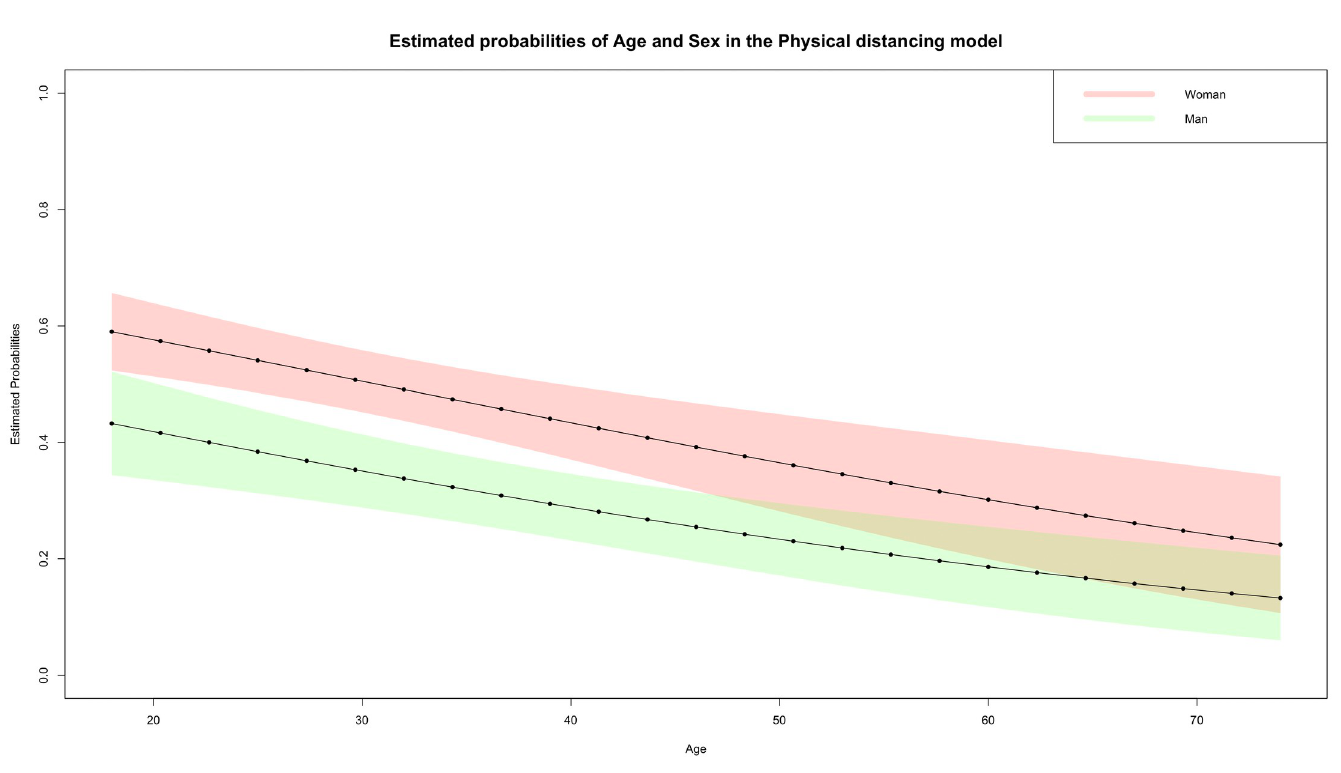
Fig 2. Probabilities estimated by logistic regression for age in the mask use (left) and hand washing (right) models with confidence intervals of 95%. The probabilities shown in the figure were estimated by a logistic regression fitted with only the significant variables at level 5%.